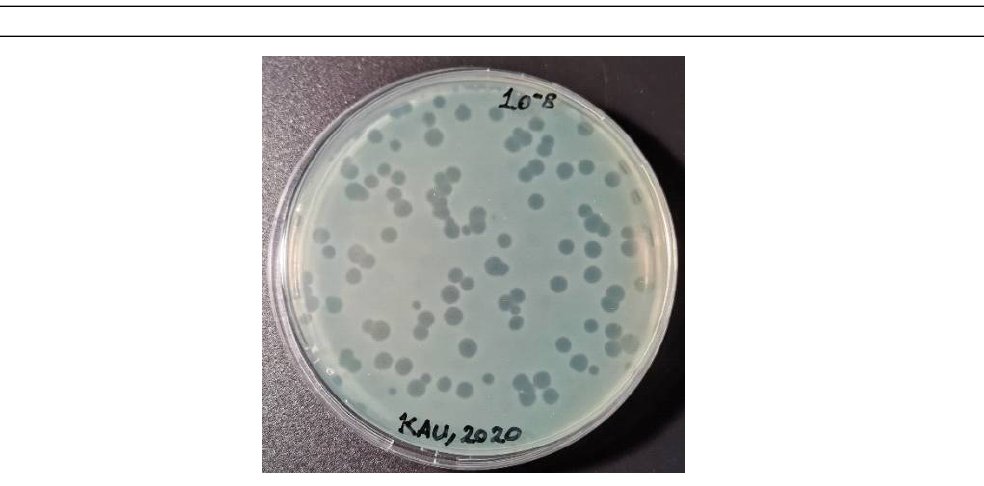
Figure 4: The isolated bacteriophage produced clear plaques ranging from 2-3 mm